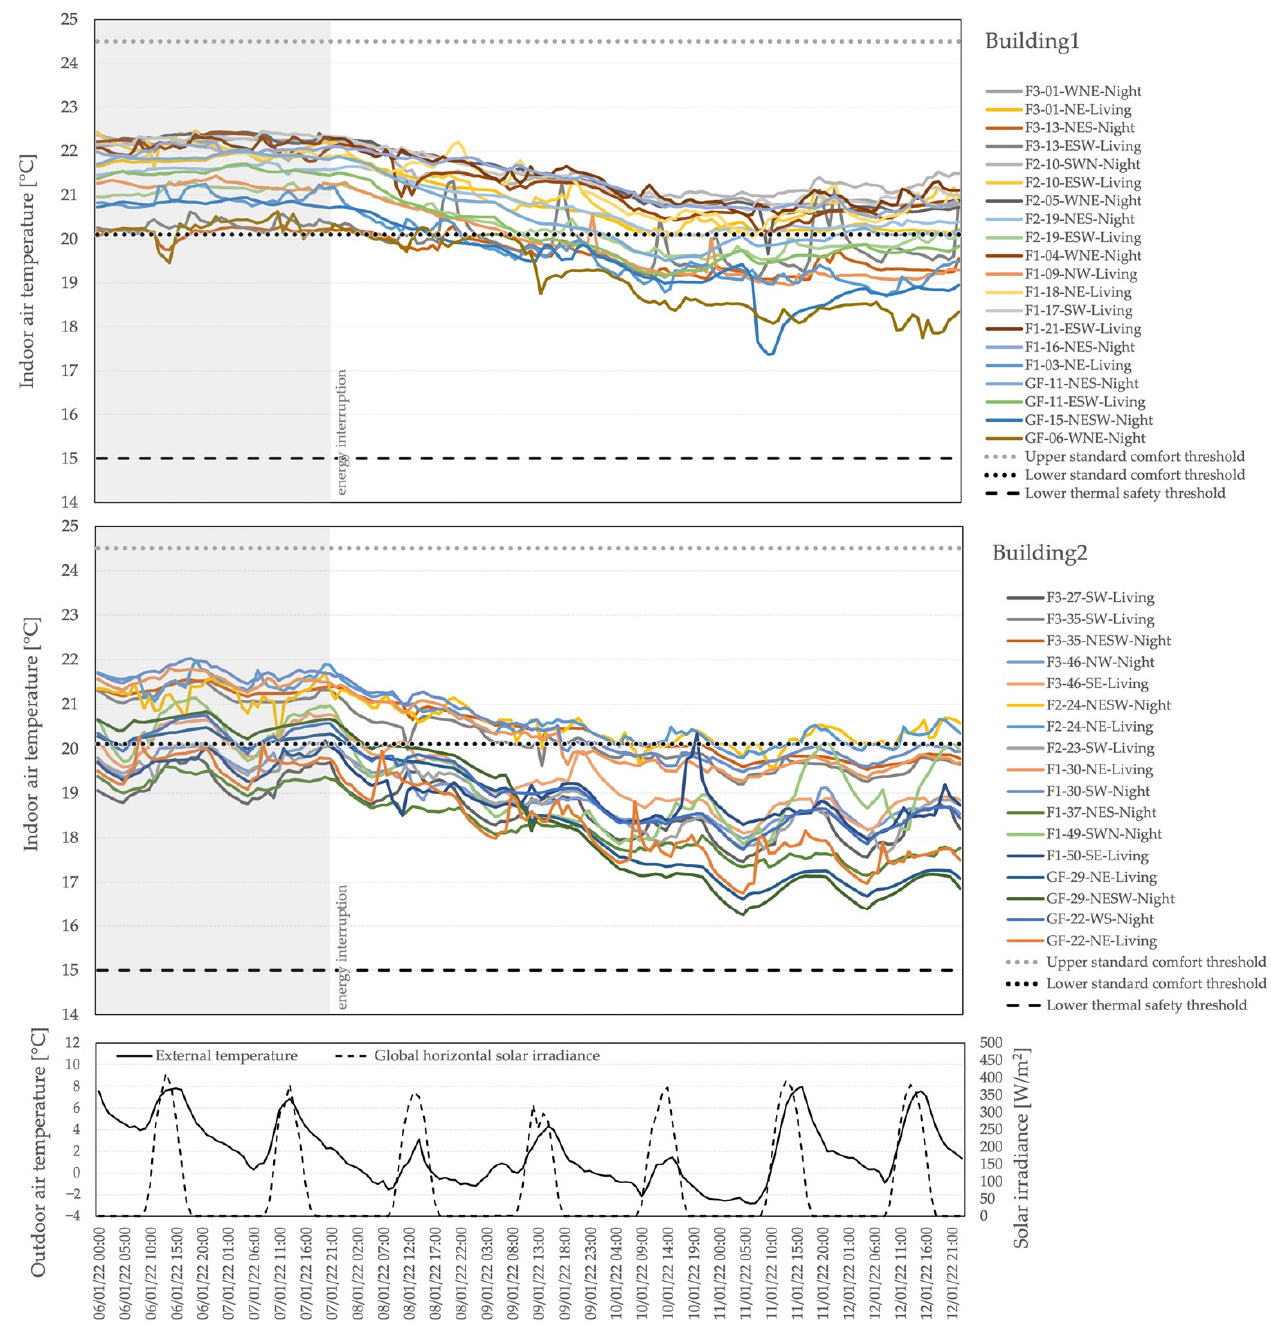
Figure 11. Measured indoor air temperature in Building 1 ( upper image ) and Building 2 ( lower image ) from 6th to 12th January 2022.